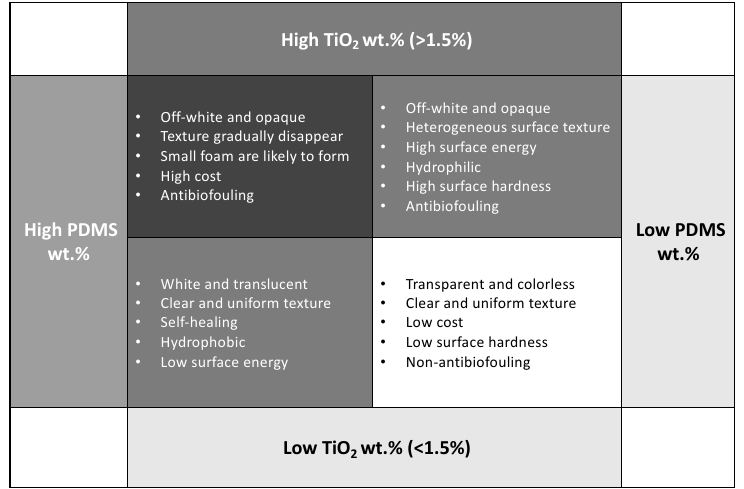
Figure 6. Different basic performance derived from coating formulation depending on weight Figure 6. Di ff erent basic performance derived from coating formulation depending on weight percentage of TiO 2 and polydimethylsiloxane (PDMS). percentage of TiO 2 and polydimethylsiloxane